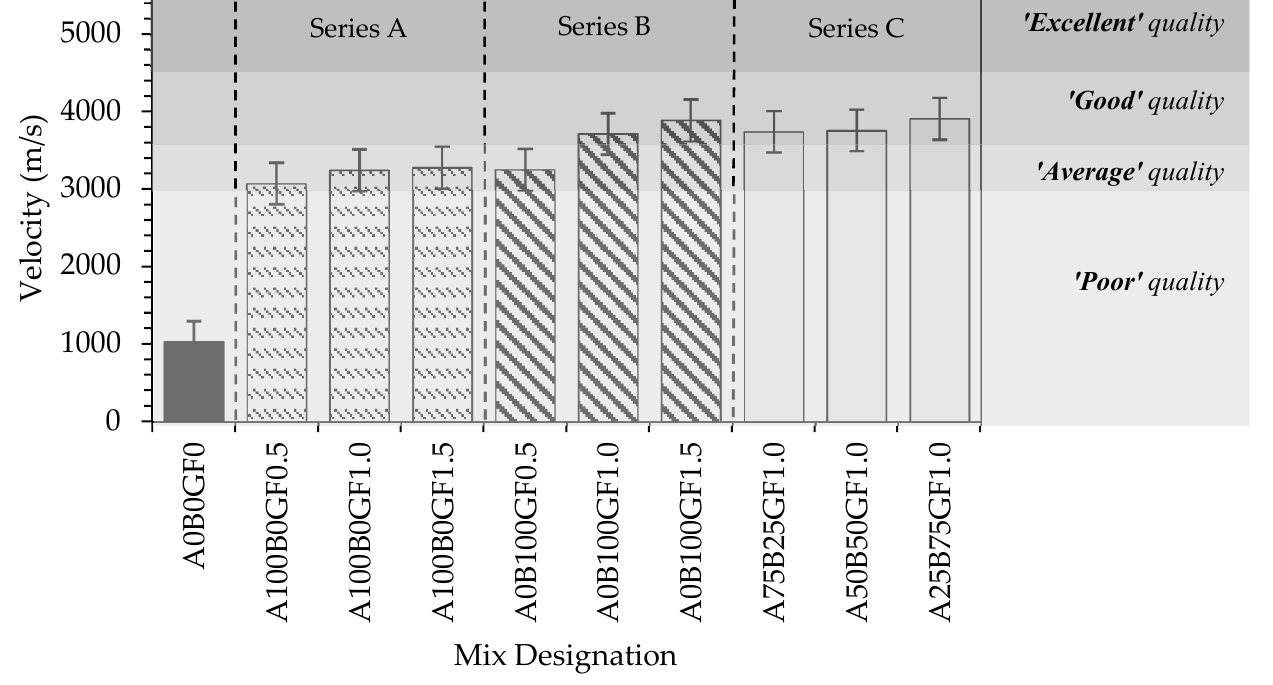
Figure 16. UPV of glass fiber reinforced geopolymer concrete.